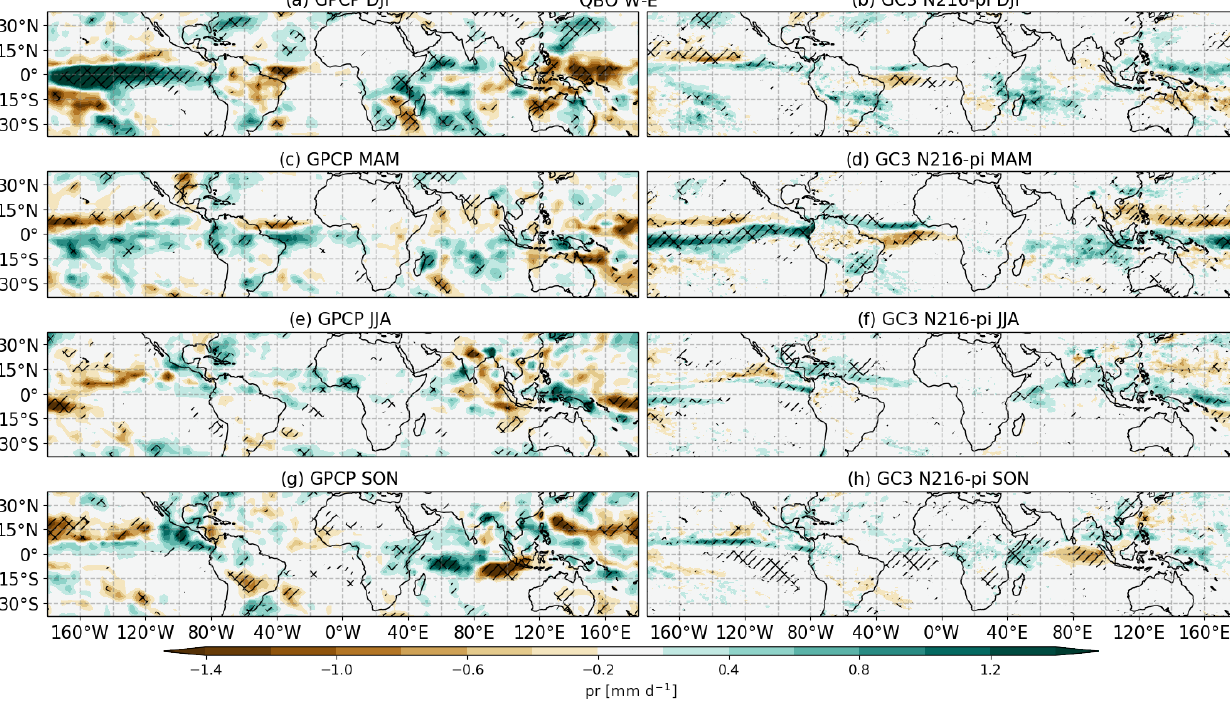
Figure 2. As in Fig. 1 but showing seasonal-mean QBO composites from (a, c, e, g) GPCP and (b, d, f, h) GC3 N216-pi for (a, b) December– January–February (DJF), (c, d) March–April–May (MAM), (e, f) June–July–August (JJA) and (g, h) September–October–November (SON) from top to